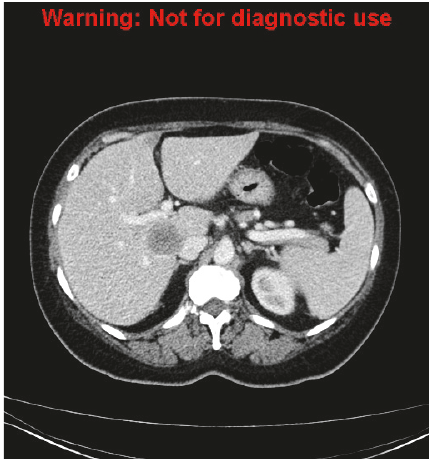
Figure 5: A new hypodense lesion in caudate lobe of the liver suspicious for